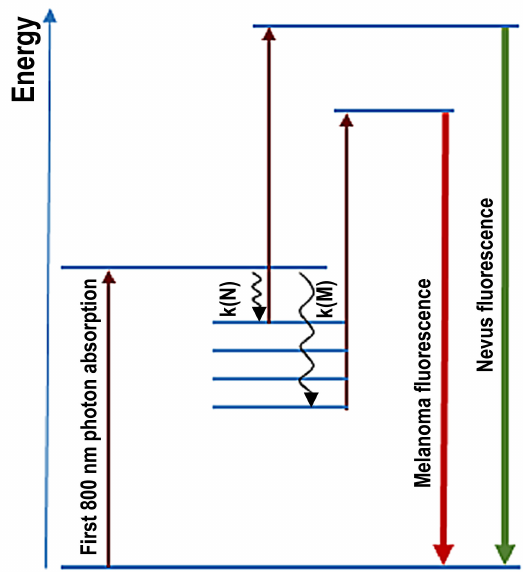
Figure 2. Simplified energy level scheme of melanin in melanosomes of nevi and of melanoma illustrates the process responsible for fluorescence spectra in the excited state: radiationless relaxation in nevi k (N) and in melanoma k (M). The relaxation includes ultrafast Franck–Condon relaxation (tuning of the core configuration to the changed excited-state electron distribution) and nonradiative vibrational